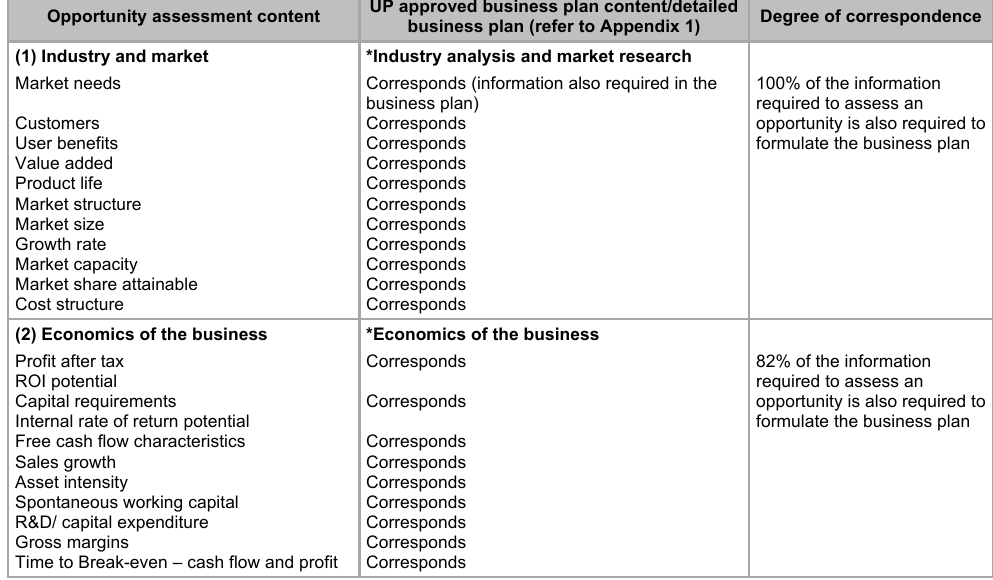
Corresponding information found in a business plan and the assessment of an opportunity Opportunity assessment